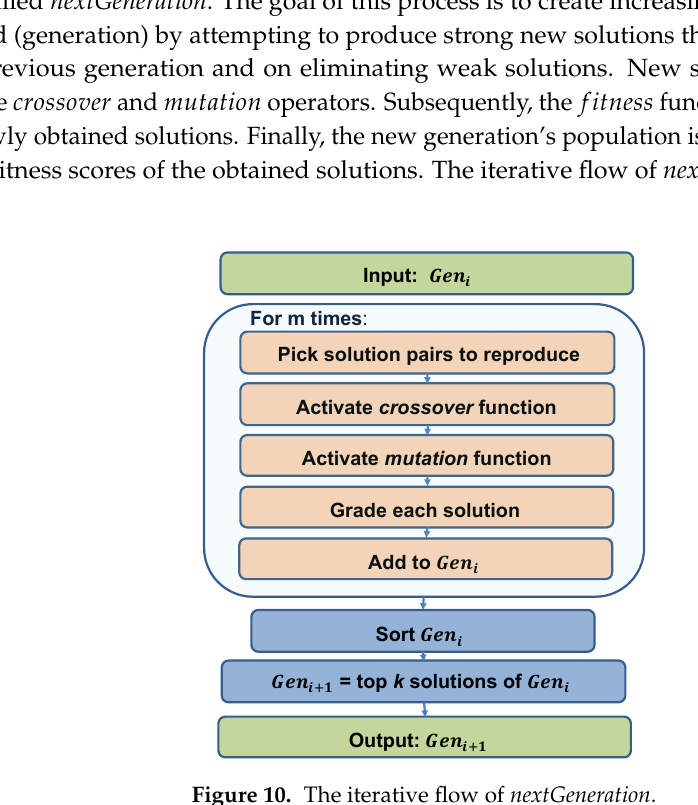
Figure 10. The iterative flow of nextGeneration